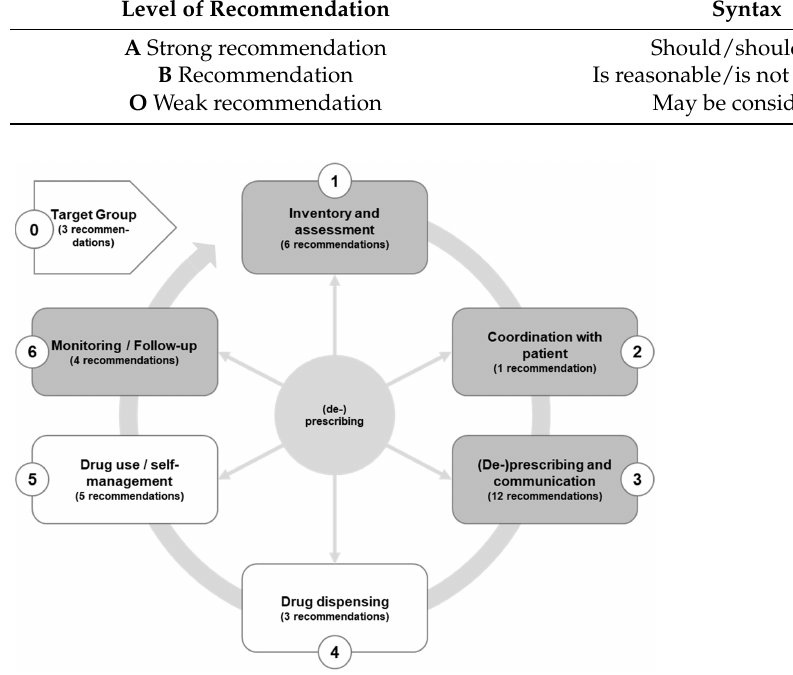
Figure 2. Medication